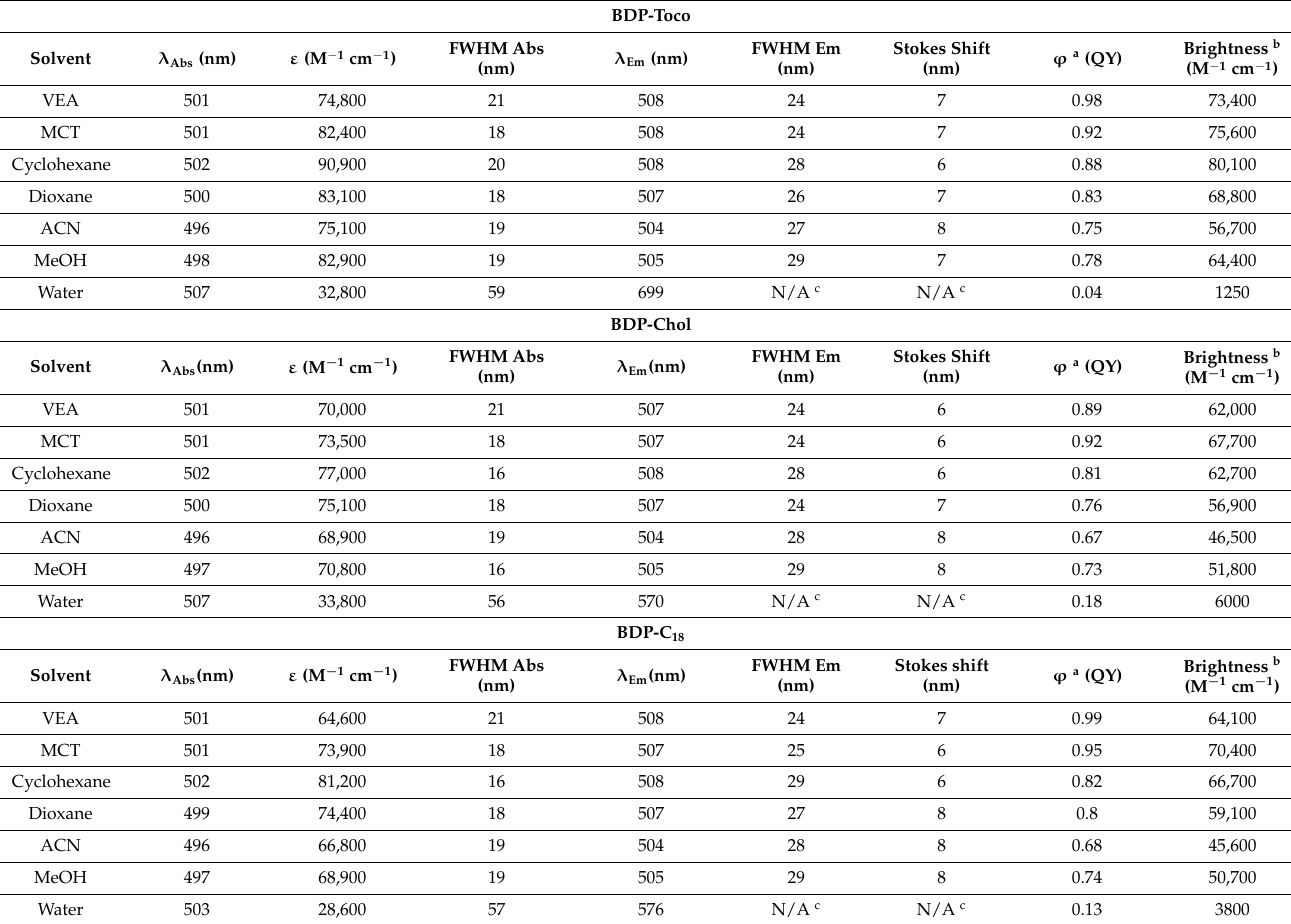
Table 1. Photophysical properties of BODIPY conjugates in various solvents and oils at 1 µ M.